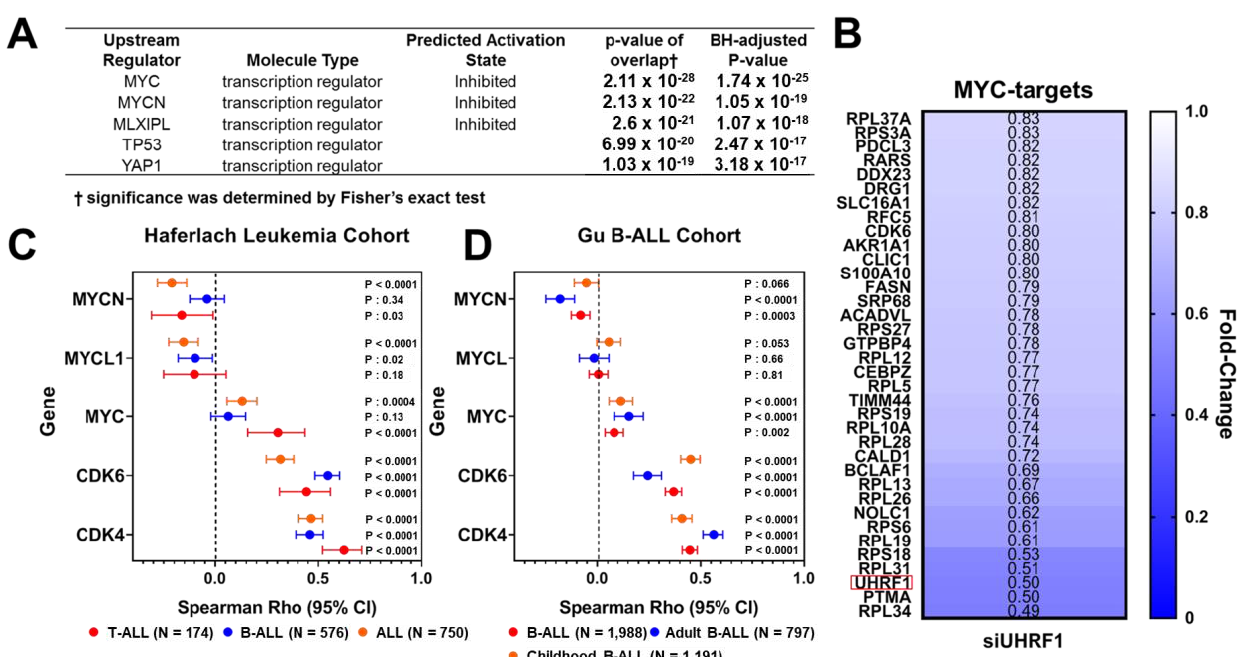
Figure 2. UHRF1 interacts with c-Myc protein. ( A ) An Ingenuity Pathway Analysis of 345 differen- tially expressed proteins (fold change ≥ 1.2 or ≤ 0.83) following a siRNA-mediated knockdown of UHRF1 in MOLT4 T-ALL cells compared with that of siControl. ( B ) Heatmap depicting fold-change in protein levels of annotated downstream MYC-targets in MOLT4 T-ALL cells following a siRNA- mediated knockdown of UHRF1 compared with that of siControl. Fold change < 1 indicates that the protein expression was reduced following a siRNA-mediated knockdown of UHRF1 . Red box high- lights UHRF1. ( C , D ) Distribution plot illustrating Spearman r coefficients (95% CI) for the associa- tion between gene expression of UHRF1 and mRNA levels of MYC, MYCL1, MYCN, CDK6, and CDK4 amongst the ALL and ALL subtypes in the Haferlach ( C ) and Gu ( D ) Leukemia Cohorts [29,30].